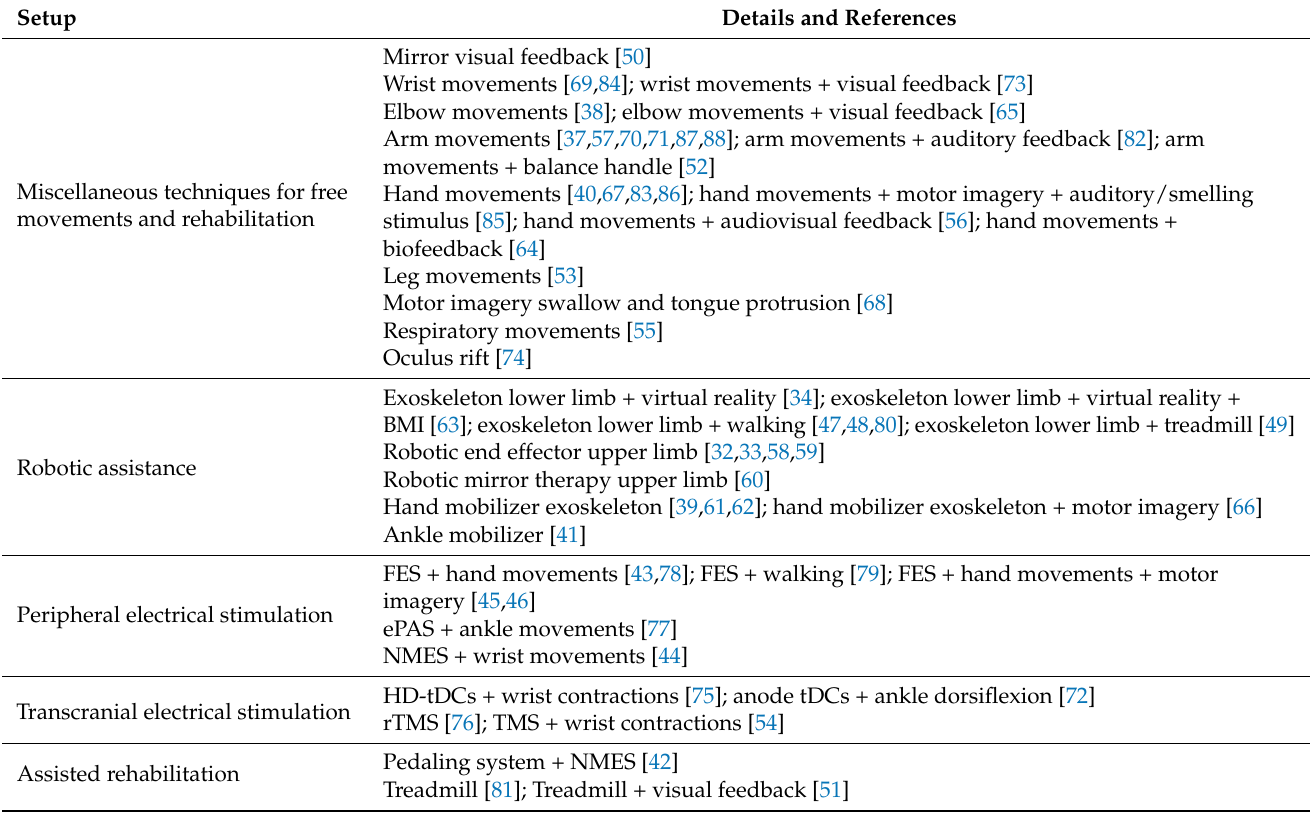
Table 3. Setup for